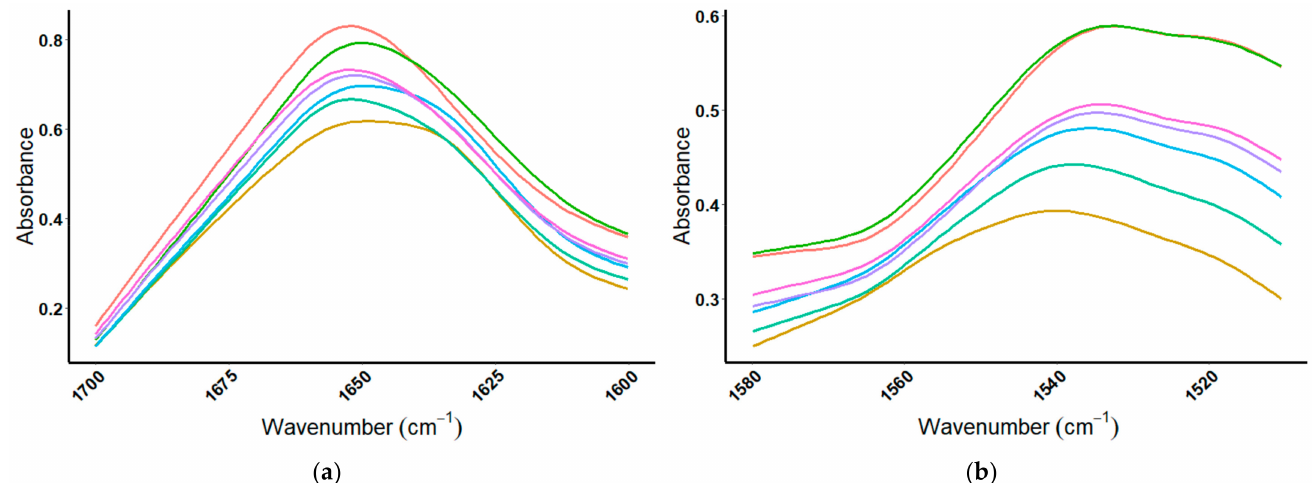
Figure 9. Amide I and amide II regions of NitroTech protein powder, bovine serum albumin (BSA), and spikes. MIR spectra showing the doping of NitroTech protein powder with BSA to a ratio of 1:10 (%m/m), where ( a ) is the amide I spectral region (1700–1600 cm − 1 ), and ( b ) is the amide II spectral region (1580–1510 cm − 1 ). = NitroTech protein powder, = Ni-